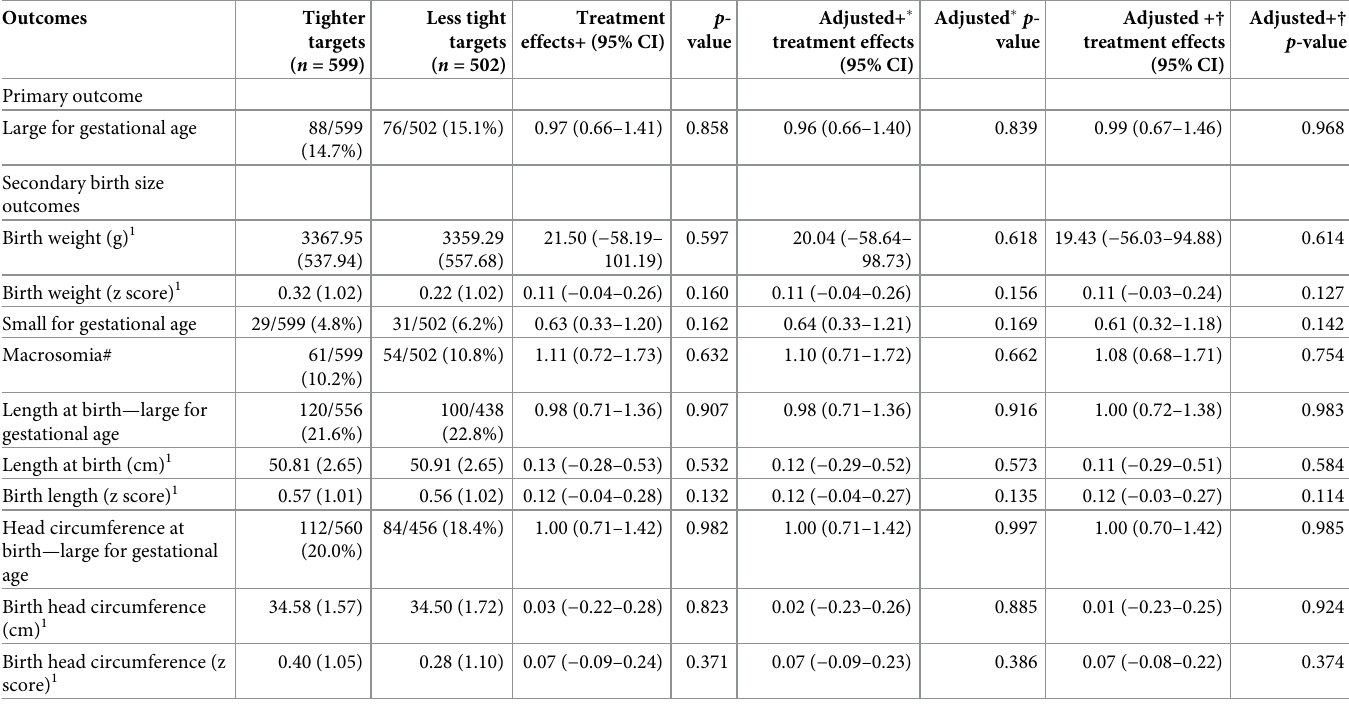
Table 2. Primary outcome and secondary birth size outcomes for the infant.